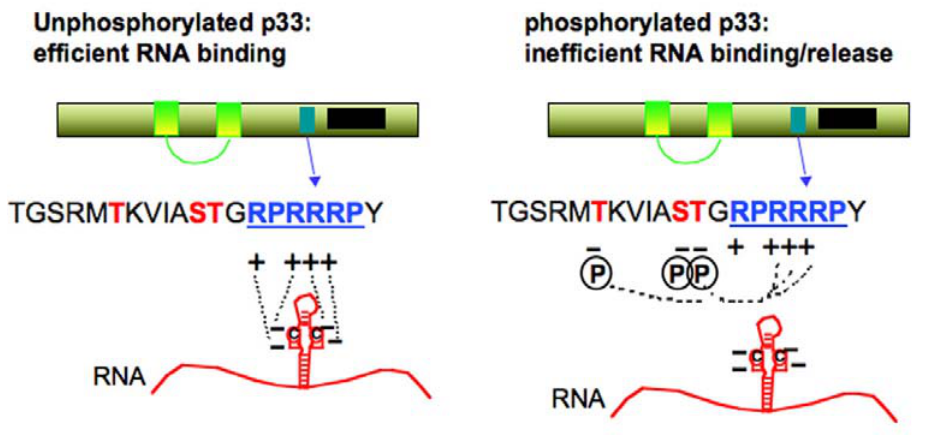
Figure 5. Schematic presentation of the phosphorylation sites in the TBSV p33 replication protein. The phosphorylated aminoacids are shown in red, while the RNA binding site is indicated with blue letters. The negative charges of phosphorylated amino acids and the positive charges of arginines are shown. Possible interactions are depicted with dotted lines. Note that the RNA has also negative charge, resulting its release from p33 after phosphorylation of p33 as shown